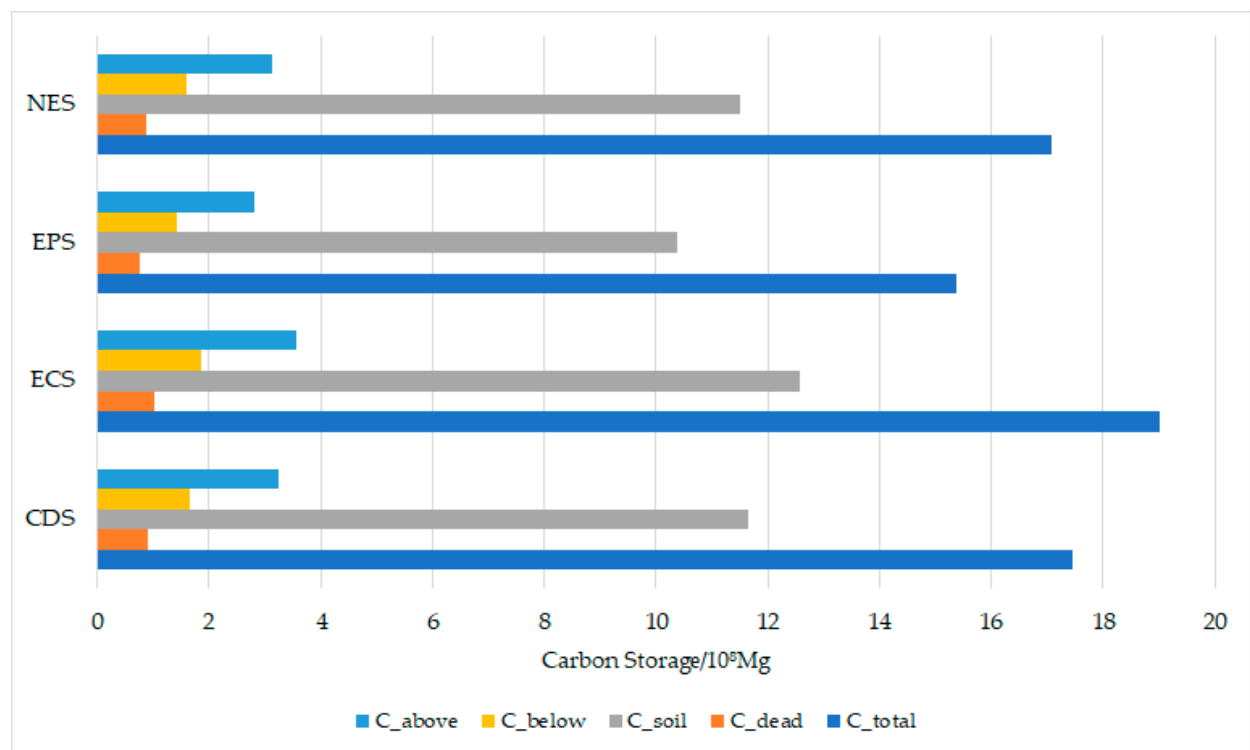
Figure 8. The predicted basic carbon storage in 2035 under four scenarios.